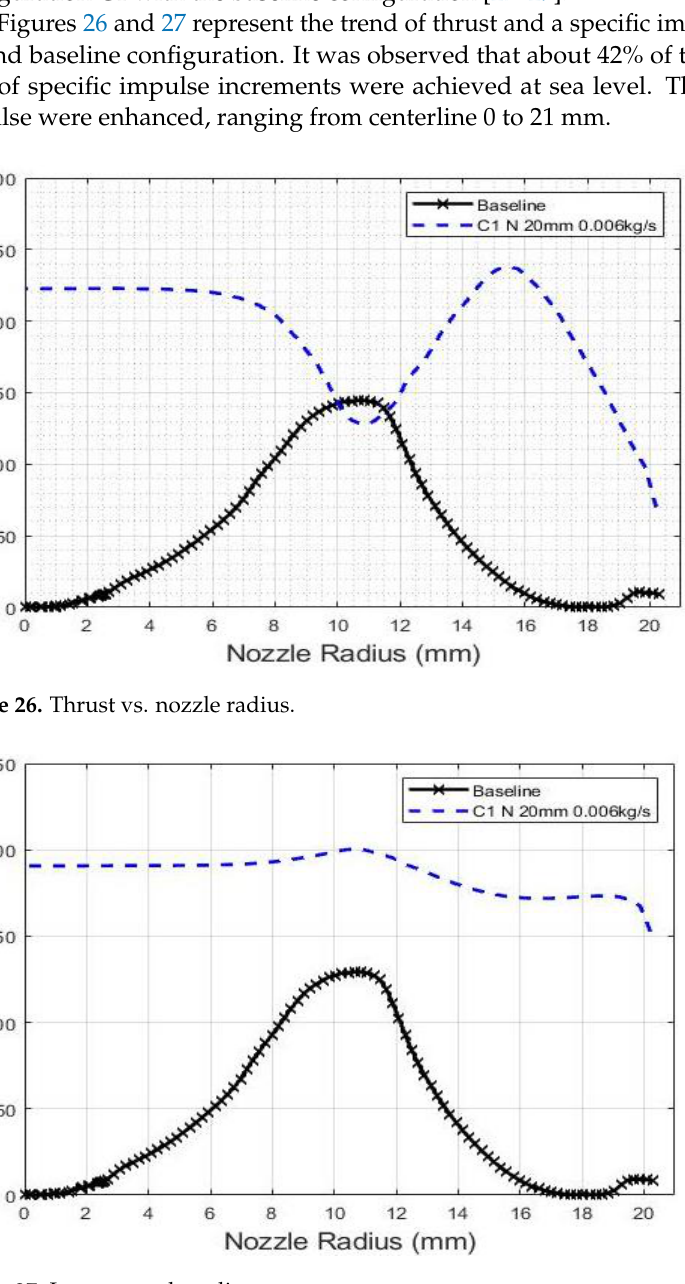
Figure 25. Mass fraction of combustion species obtained from CFD.